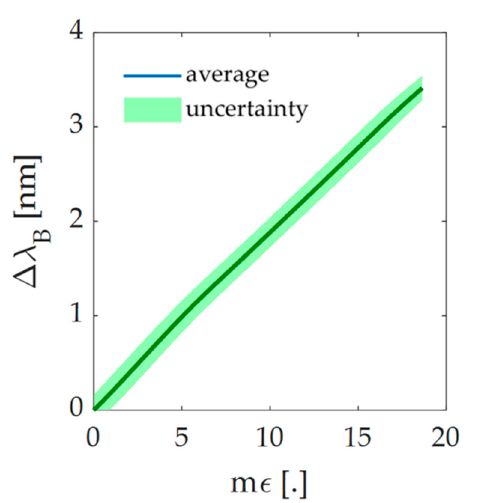
Figure 4. Response to strain of the sensing element. Trend of the calibration curve (blue curve) and its uncertainty (green shadow).